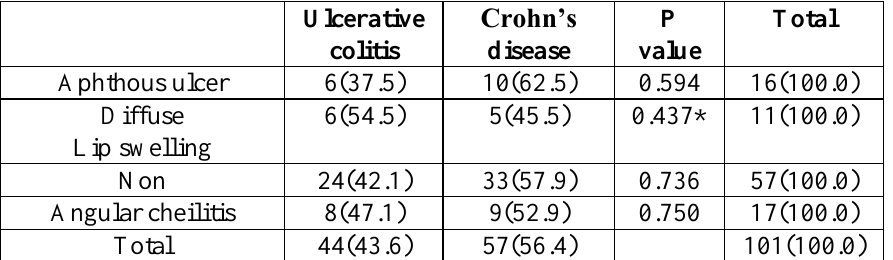
Table (3) Oral manifestation in patients with ulcerative and Crohn’s